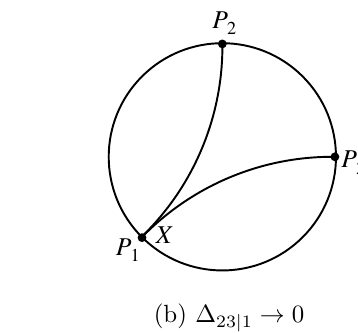
Figure 8. Two different limits of the three-point diagram with ∆ 2 = ∆ 3